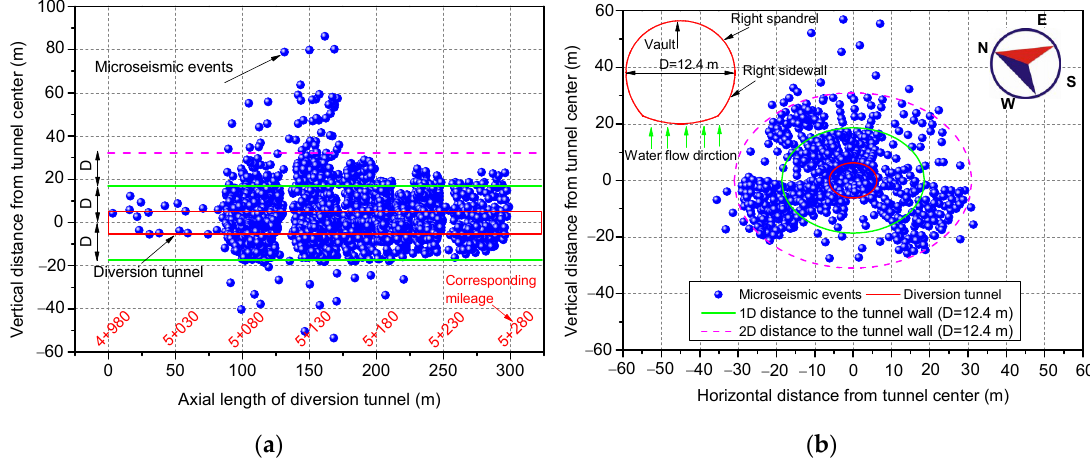
Figure 10. Spatial distribution of MS events: ( a ) Longitudinal section; ( b ) Cross section.